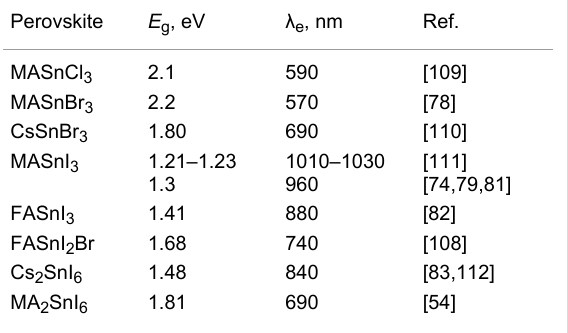
Table 2: Bandgap and approximate absorption band edge position ( λ e ) of selected Sn-based hybrid perovskites. Perovskite E g ,